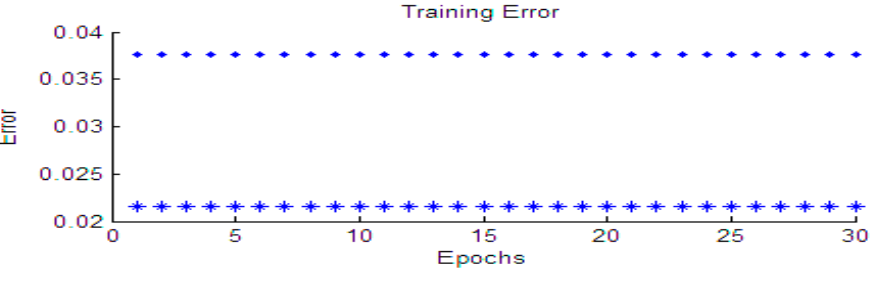
Figure 7. Changes in the training and checking data error.